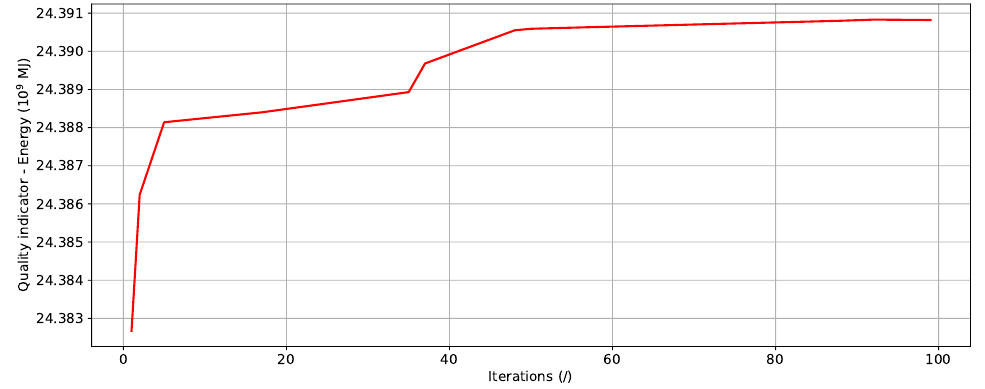
Figure 5. Change of the quality indicator in subsequent